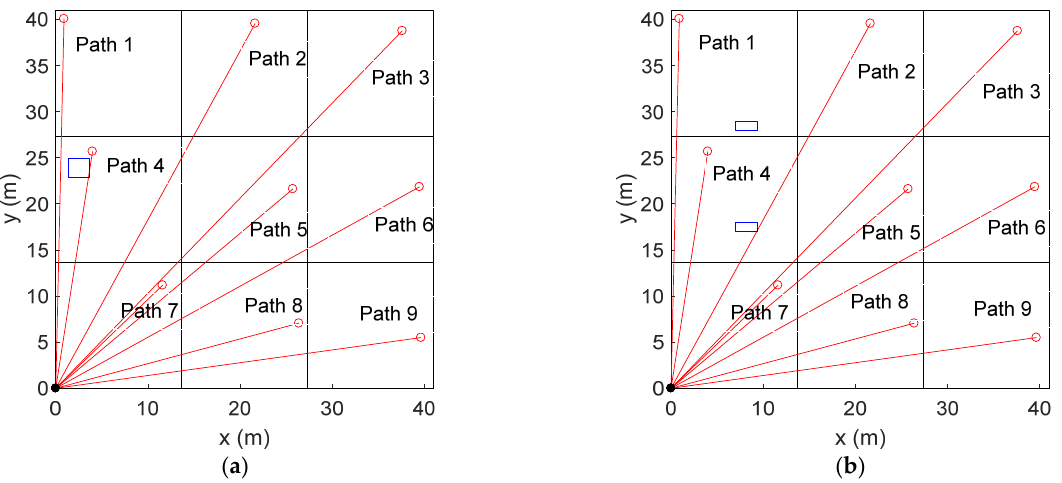
Figure 6. The source and path configurations: ( a ) Release One and ( b ) Release Two. The small rectangles represent area sources. Table 1. Parameters of the releases.